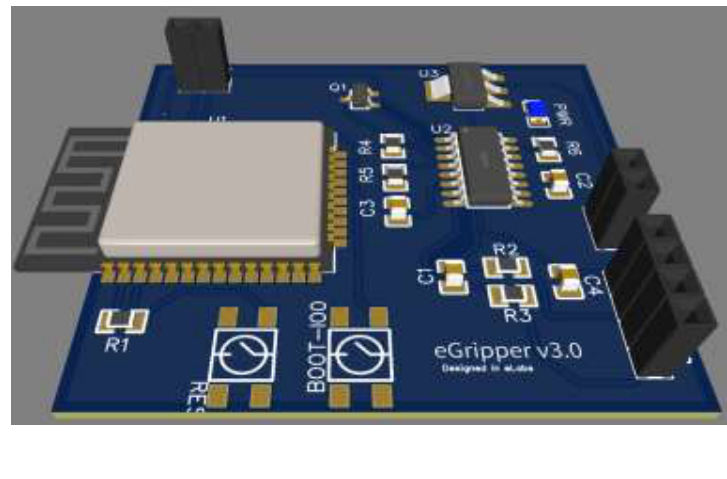
Figure 4 Printed Circuit Board (PCB)